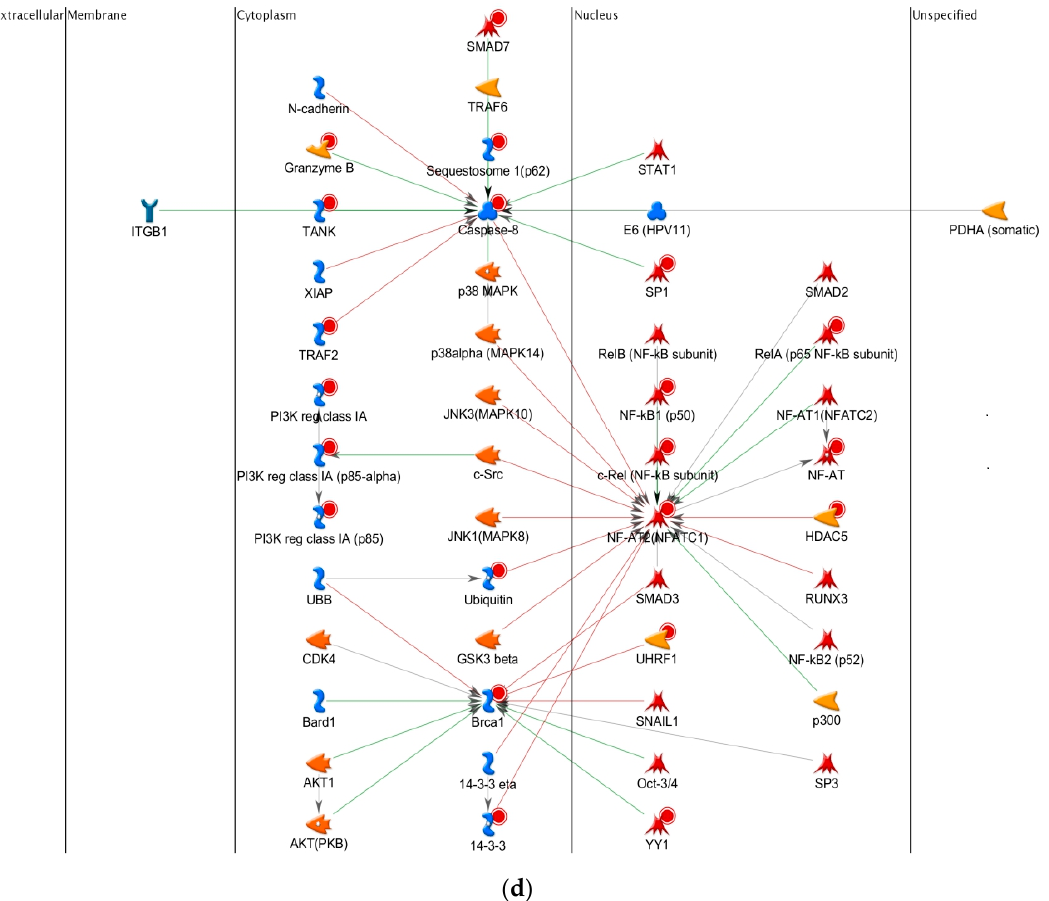
Figure 6. Top-scoring networks for ( a ) 4 h; ( b ) 8 h; ( c ) 24 h; and ( d ) 72 h post-TBI. Scoring was based on the number of pathways. Thick cyan lines indicate fragments of canonical pathways. Up-regulated genes are marked with red circles, and down-regulated with blue circles. A “checkerboard” pattern indicates mixed expression for the gene between files or between multiple tags for the same gene. These figures were generated by MetaCore™.